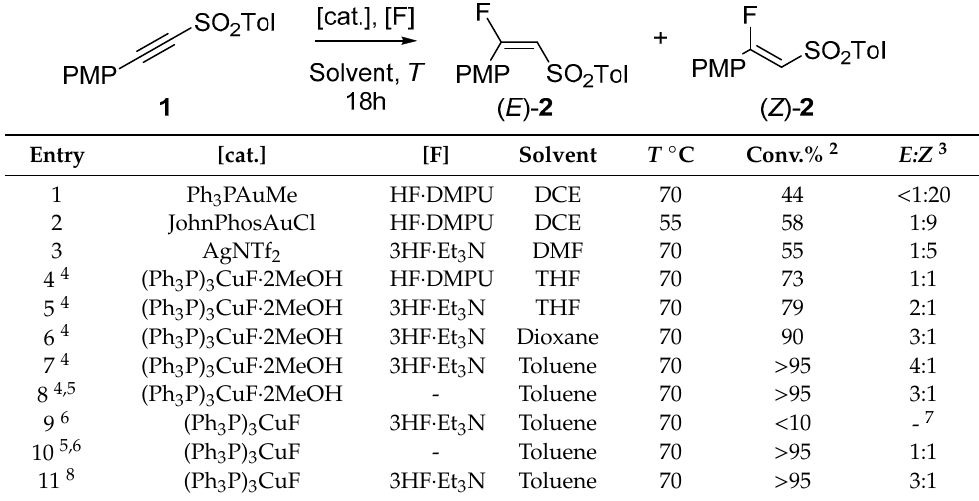
Molecules 2019 , 24 , x Table 1. Optimization of the syn -hydrofluorination procedure towards ( E )- β -fluorovinyl sulfones 1 .